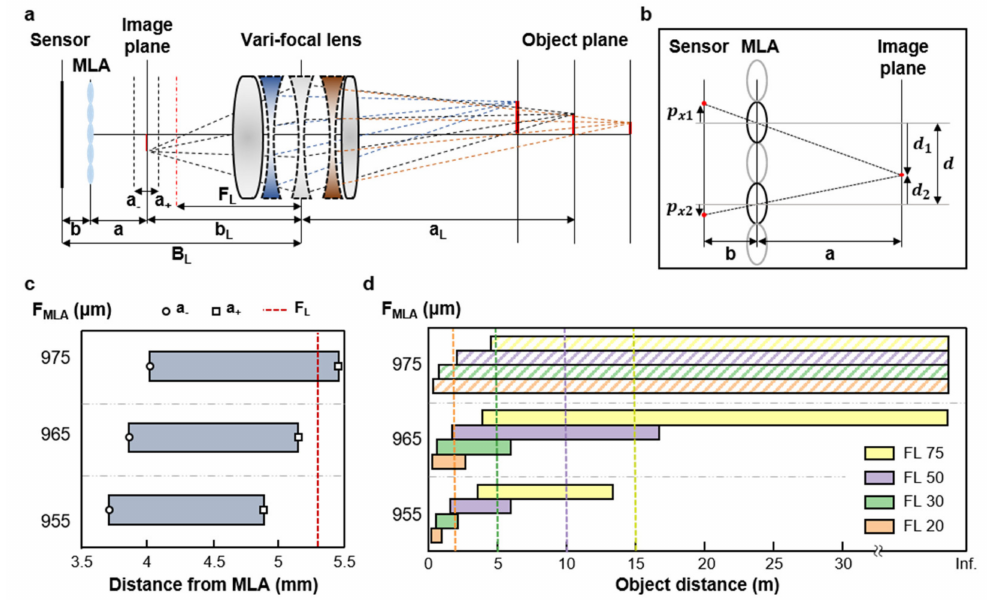
Figure 2. ( a ) Schematic of the VF-LFC system with main design parameters. ( b ) Schematic of the optical path through the MLA between the image sensor and the image plane of the main lens. ( c ) The image side DoF, a + and a − , are calculated from the thin lens equation for a focal length of MLA. ( d ) The object side DoF for each focal length of a vari-focal lens according to the MLA focal length, the dotted lines are the boundaries between measurement regions of each focal